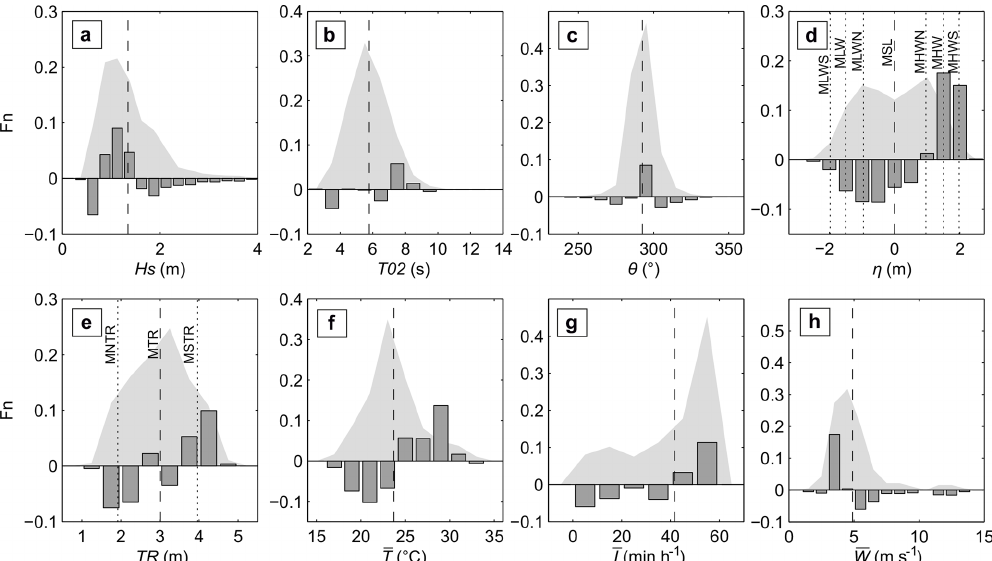
Figure 4. Environmental controls on shore-break-related SZIs: normalised frequency distributions, Fn , during the summers of 2007, 2009 and 2015 (light grey region), referred to as “average” background distribution, of (a) significant wave height, Hs ; (b) mean wave period, T 02; (c) wave direction, θ ; (d) water level, η ; (e) daily tide range, TR; (f) daily mean air temperature, T ; (g) daily mean hourly insolation, I ; and (h) daily mean wind speed, W . The dark grey bars show the difference between surfing-related and average background distributions and vertical dashed lines show the background mean.